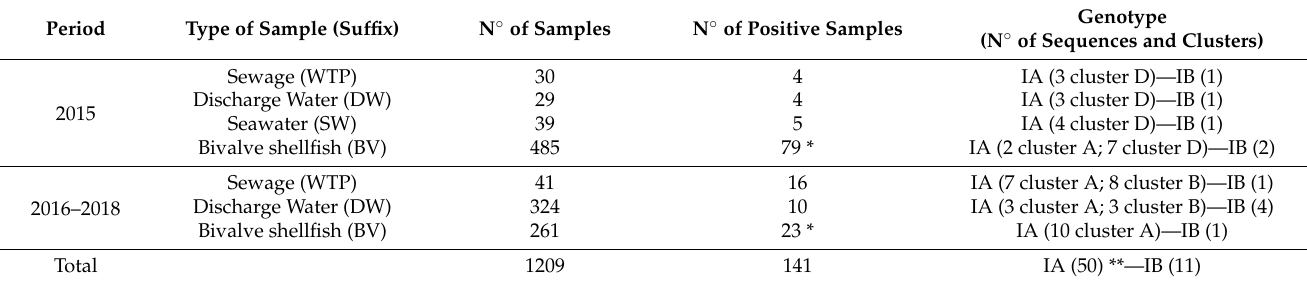
Table 2. Distribution of Hepatitis A Virus (HAV)-positive samples and of genotypes/variants according to year and source of